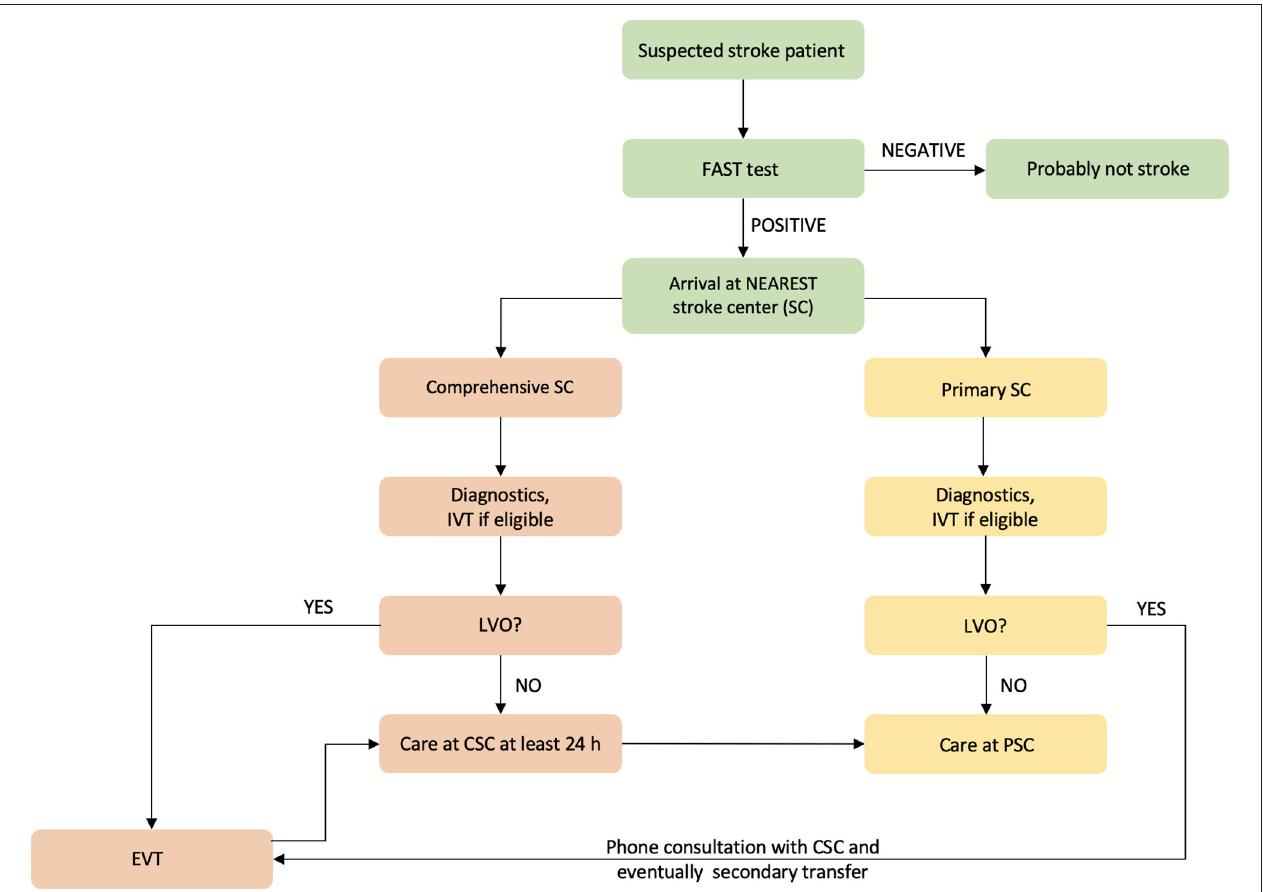
FIGURE 1 | Flowchart of prehospital triage in the Moravian–Silesian region, Czech Republic, before the triage change. IVT indicates intravenous thrombolysis; EVT, endovascular treatment; and LVO, large vessel